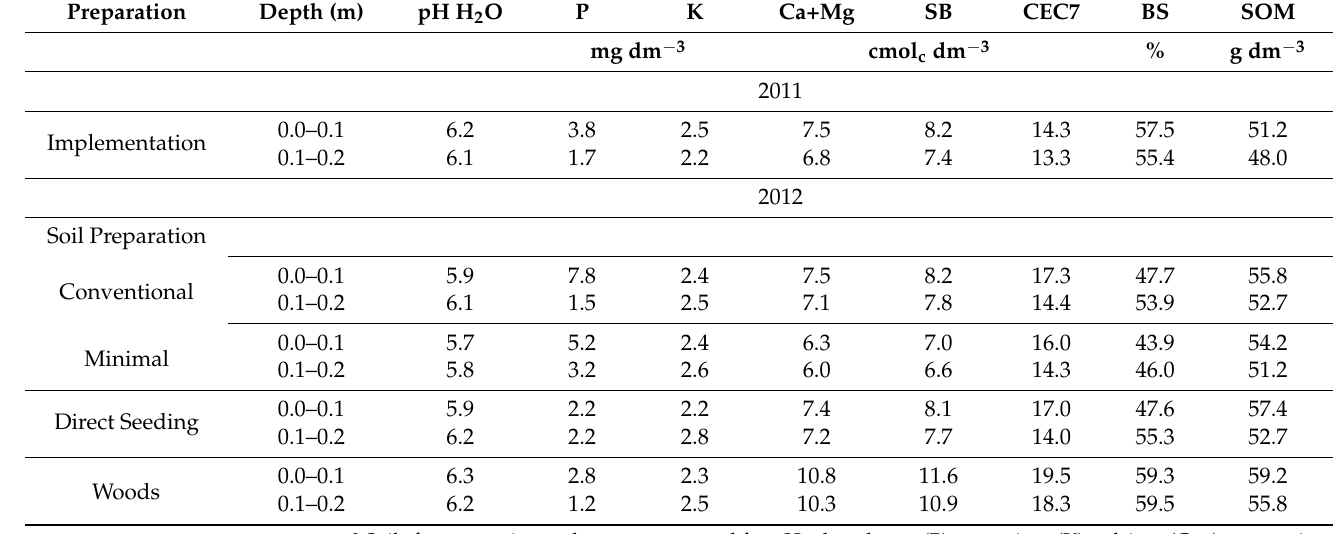
Table 1. Chemical attributes a of soils with different preparations under the cultivation of irrigated wheat in 2011 and 2012 in Tangar á da Serra, Mato Grosso state, Brazil.